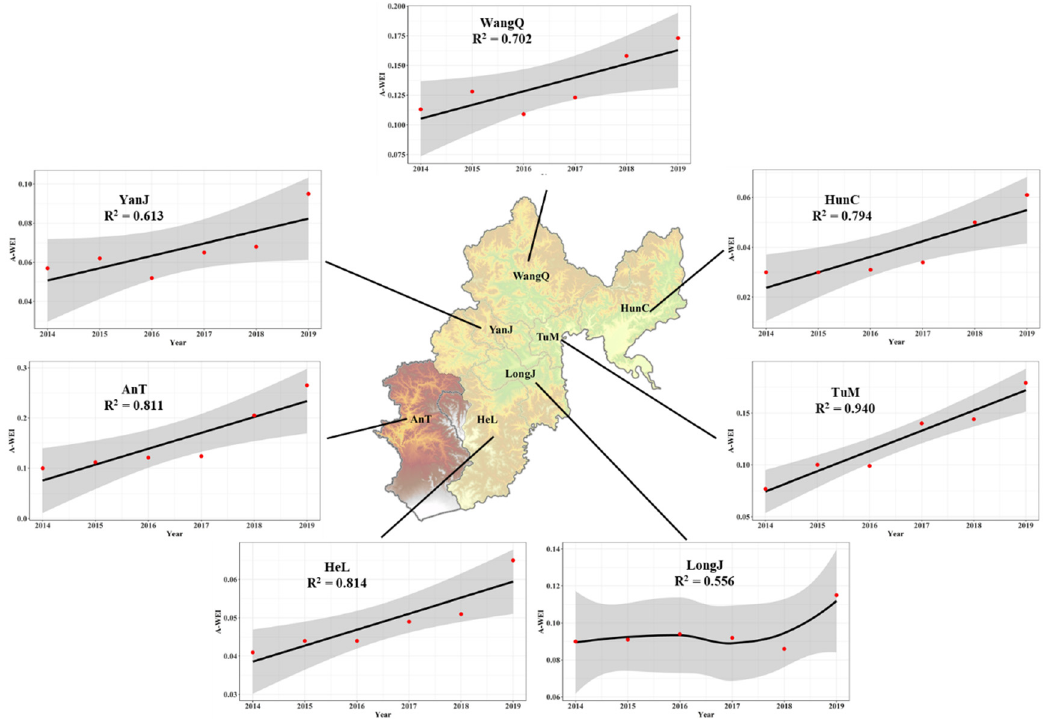
Figure 9. The trend of agricultural water efficiency from 2014 to 2019.